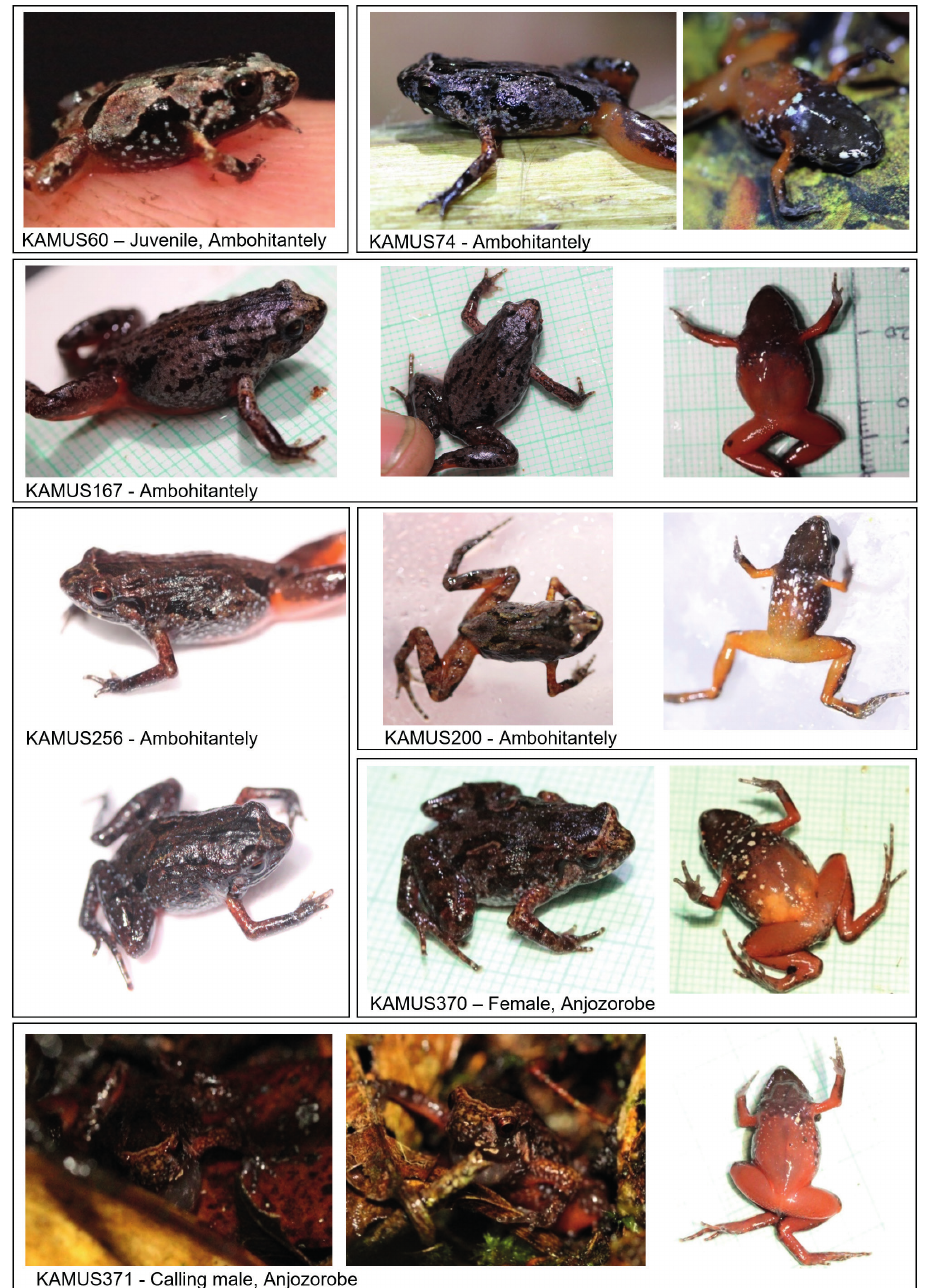
Figure 7. Images of the additional observed specimens of Stumpffia lynnae sp. nov. including the calling male